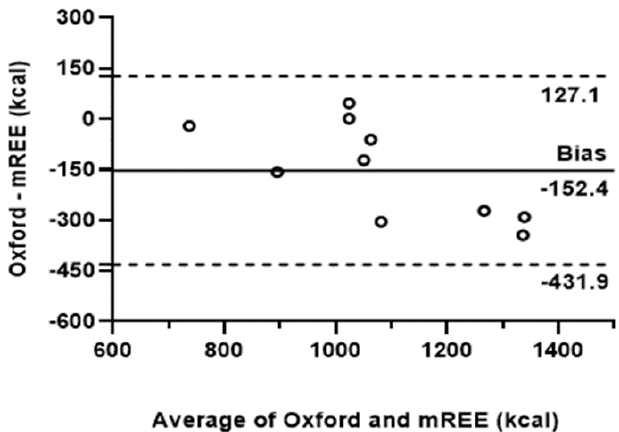
Figure 3. Agreement between the Oxford predictive equation and indirect calorimetry of subjects with RDEB ( n = 10). m-REE: measured energy expenditure .